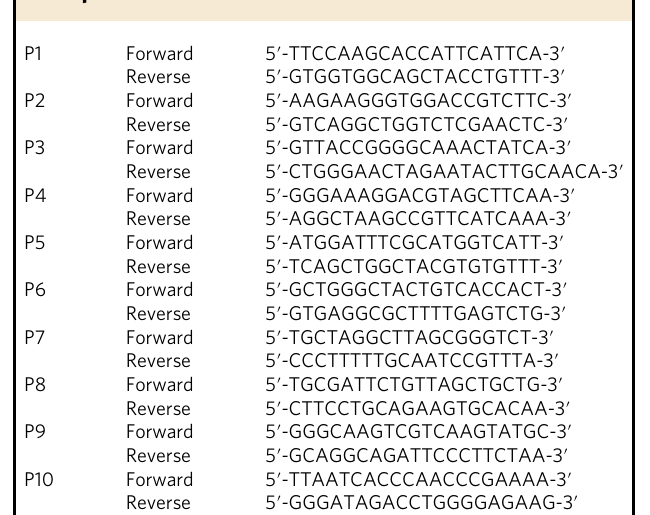
Table 3 DNA sequences of the 10 primers spanning the SKP2